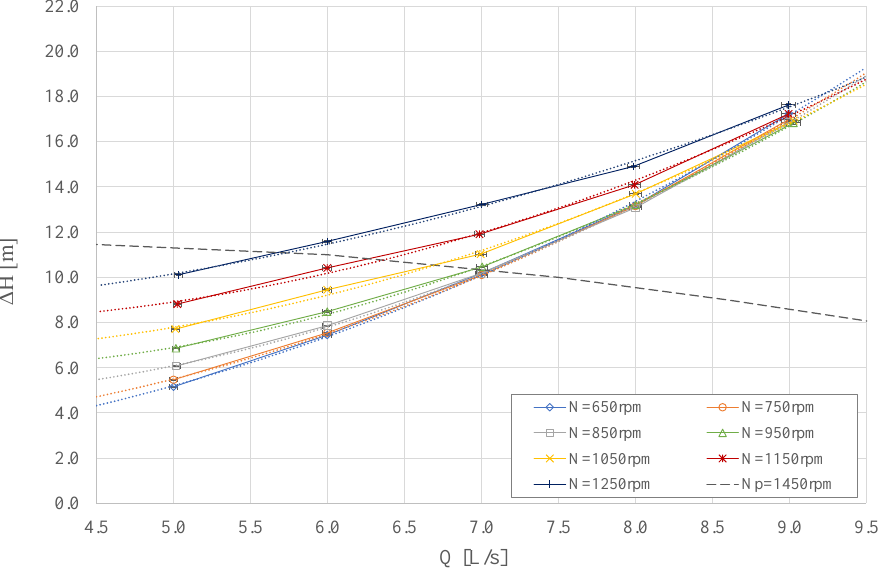
Figure 5. PAT characteristic curves (solid lines and symbols) referring to a specific rotational speed N . Interpolations are also shown (dotted colored lines). The curve referring to the pump working in classical mode at N = 1450 rpm is also shown (dashed